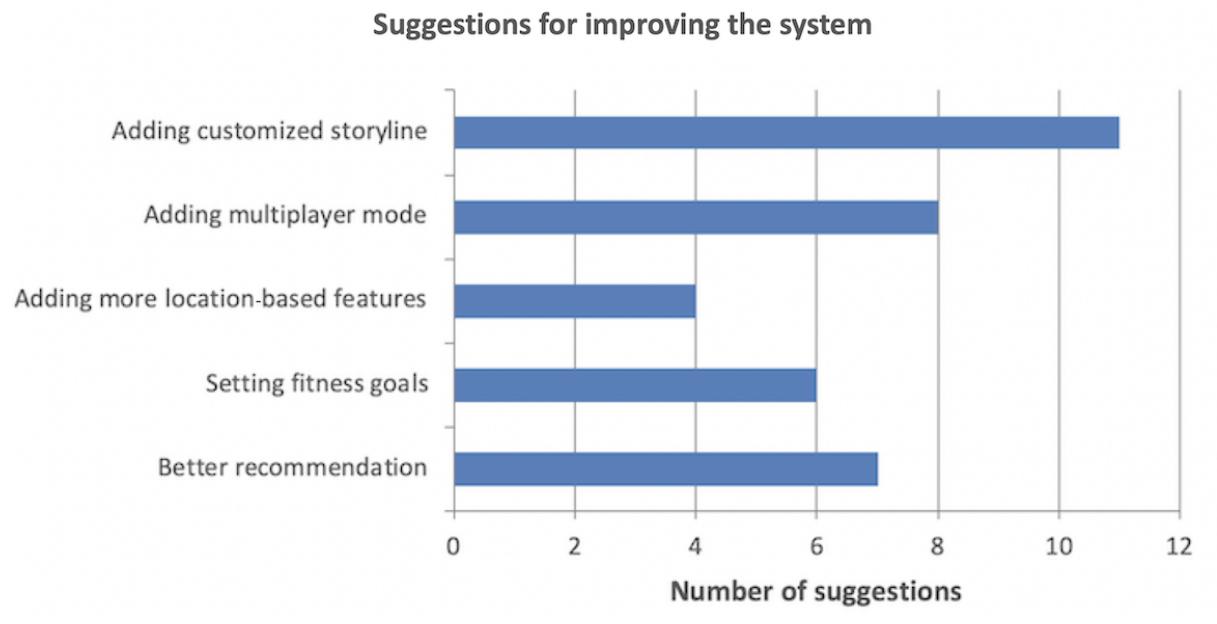
Figure 13. Number of main suggestions received from open-ended questions for improving our